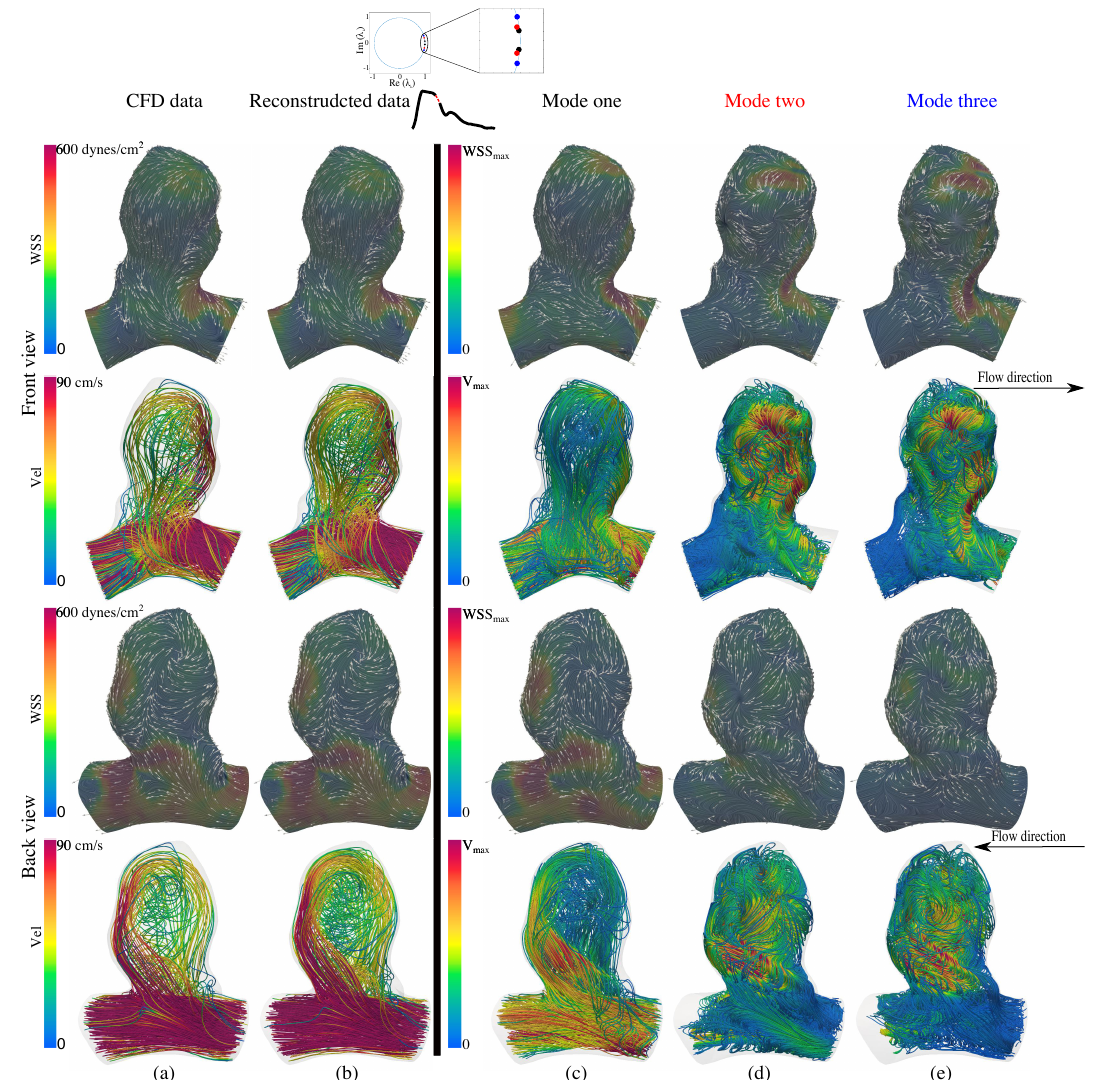
Figure 9. Velocity and WSS CFD data and the mDMDc modes are shown in the fourth stage of the cerebral aneurysm model. The stage is highlighted with a red dashed line in the flow waveform. The location of discrete eigenvalues in the unit circle corresponding to the selected mDMDc modes are shown. Velocity and WSS streamlines are shown and colored by their magnitude. WSS vectors are normalized and shown on top of the WSS streamlines to show the WSS vector direction. ( a ) CFD data (time = 0.29 s), ( b ) reconstructed data with 95% accuracy, ( c ) real part of the mDMDc mode corresponding to the eigenvalue λ = 0.99 ± 0.07 i , ( d ) real part of the mDMDc mode corresponding to the eigenvalue λ = 0.96 ± 0.20 i , ( e ) real part of the mDMDc mode corresponding to the eigenvalue λ = 0.95 ± 0.29 i